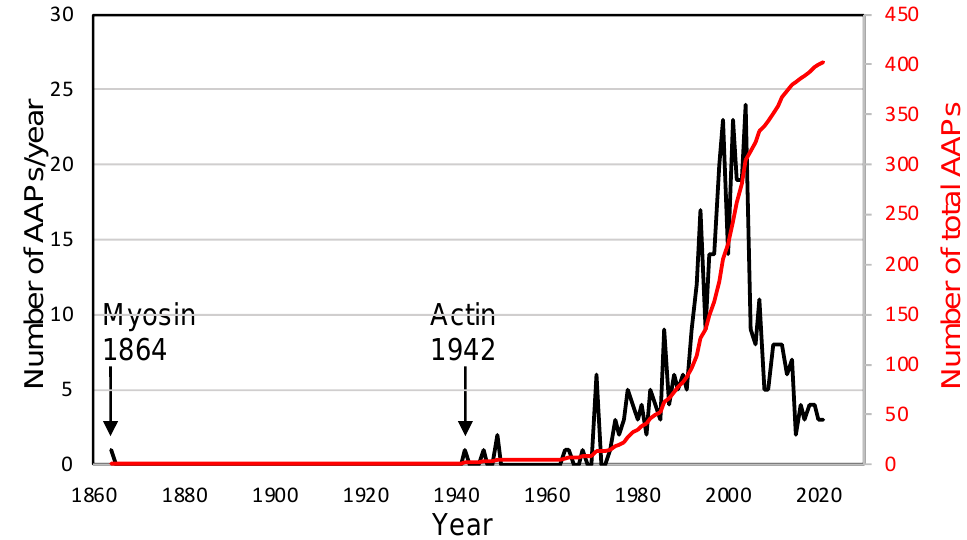
Figure 1. The number of actin-associated proteins (AAPs) published by year.